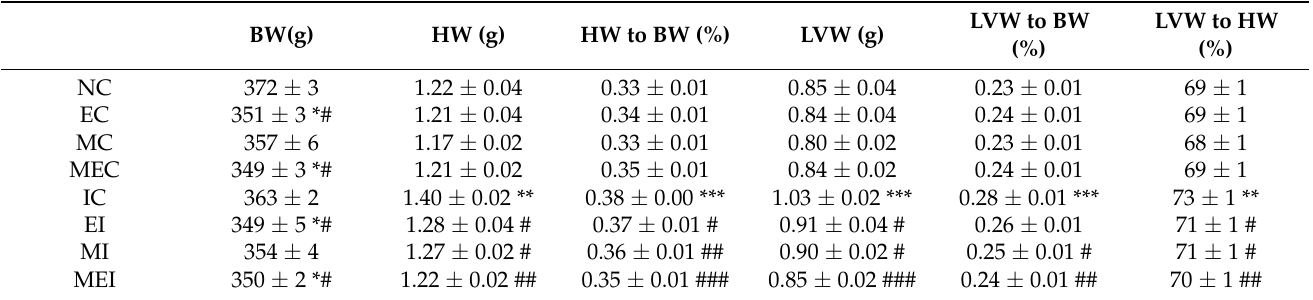
Table 2. Effect of exercise and melatonin supplementation on body and heart tissue weight in rats with or without isoproterenol